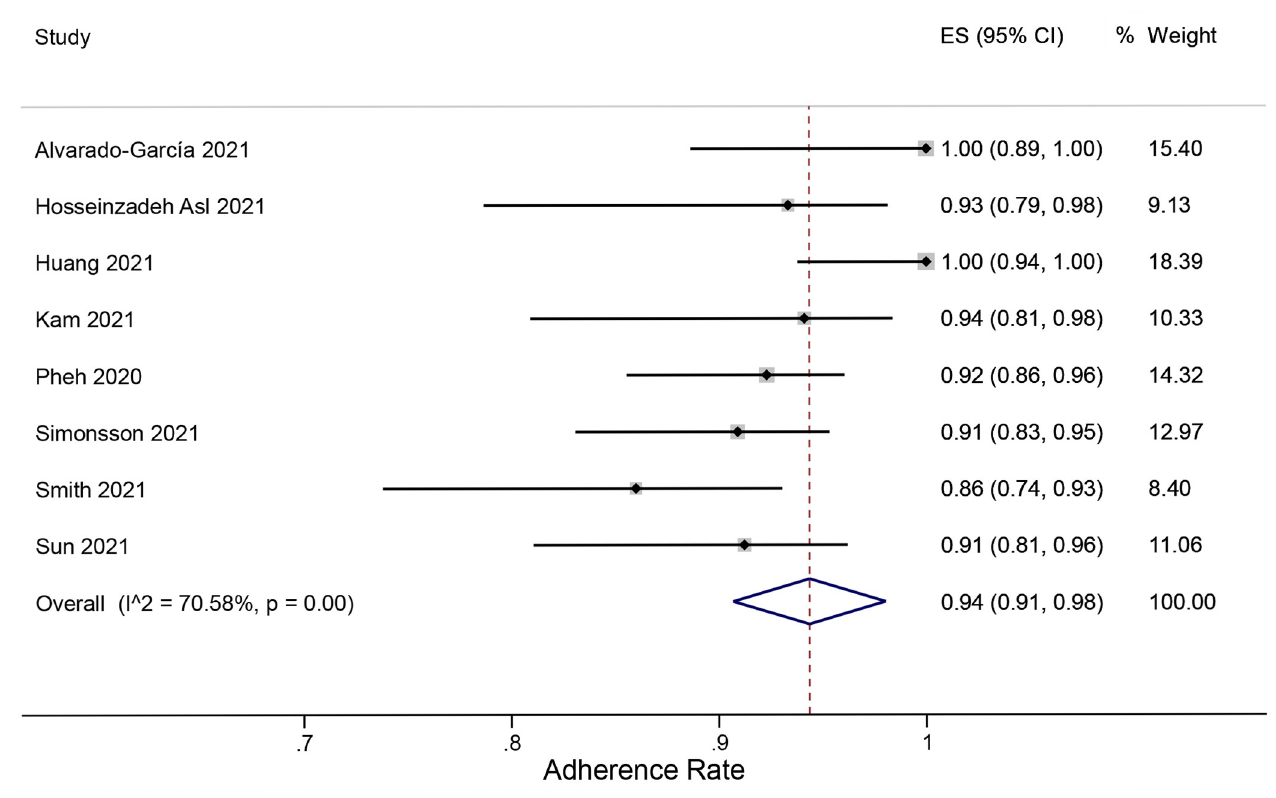
Fig 3. Forest plot of meta-analysis of proportions for adherence rate to online